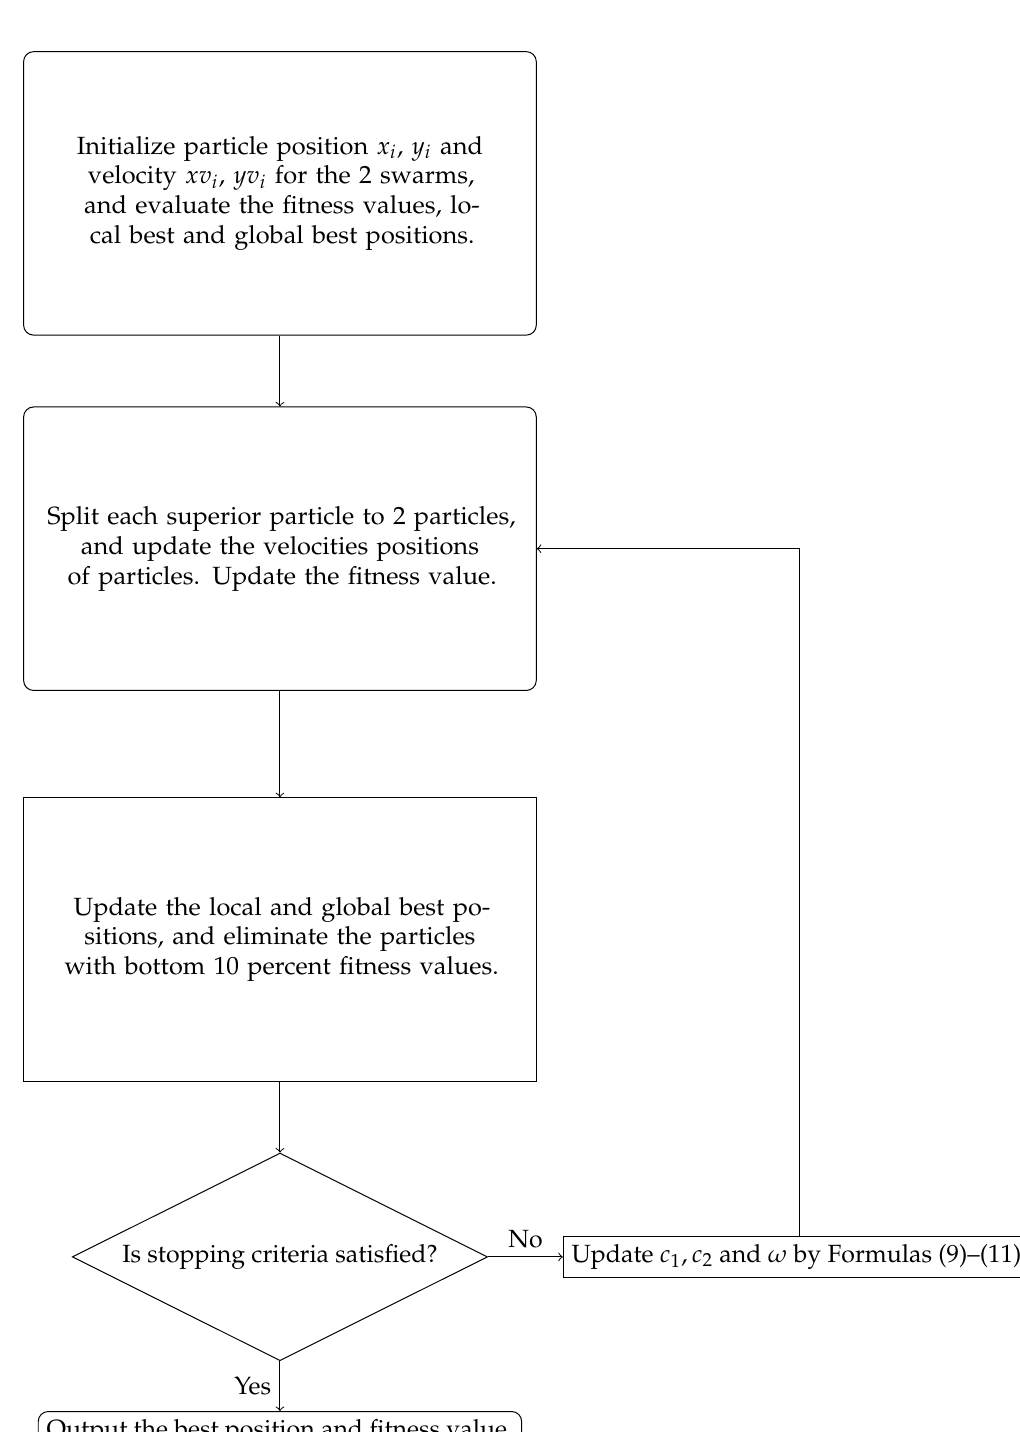
Figure A2. Flowchart of Algorithm